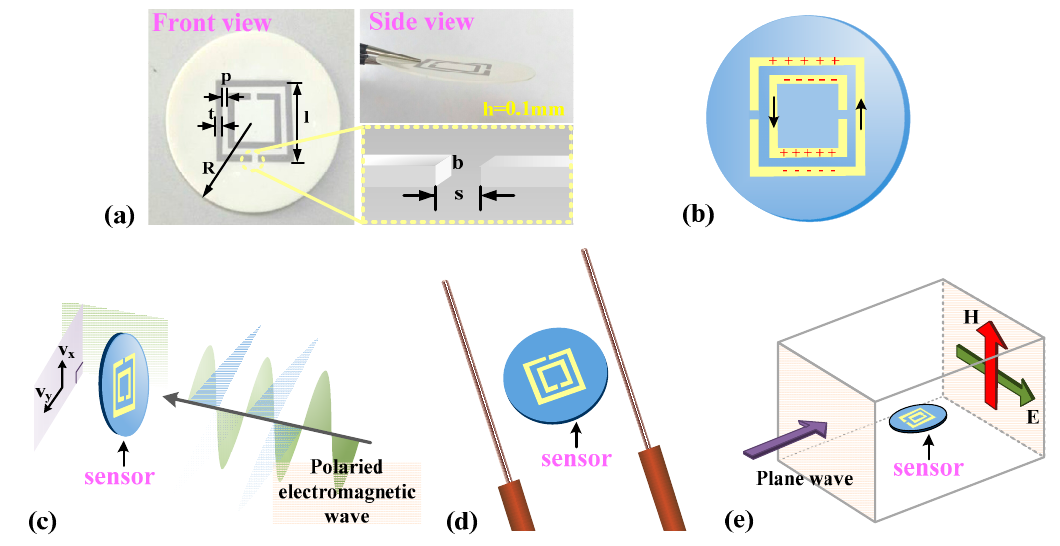
Figure 2. ( a ) Fabricated sensor displayed in front views. ( b ) Charge distribution in the metal rings when sensor irradiated in electromagnetic wave. Possible relative positions of the antenna and sensor ( c ) the sensor is irradiated by polaried electromagnetic wave ( d ) the sensor is placed between a pair of monopole antennae ( e ) the sensor is placed in vacuum waveguide.